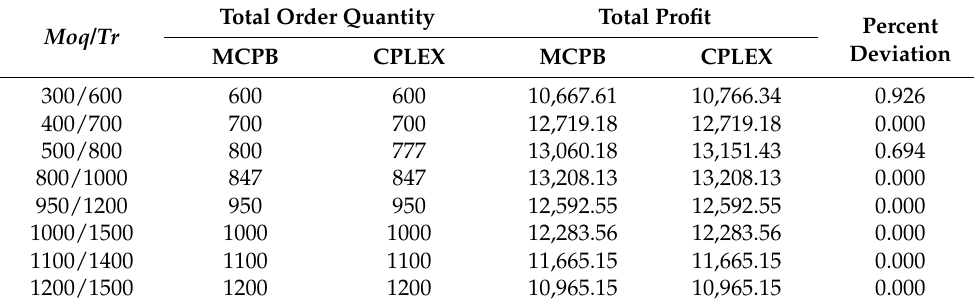
Table 5. The comparison of output under different scenarios.